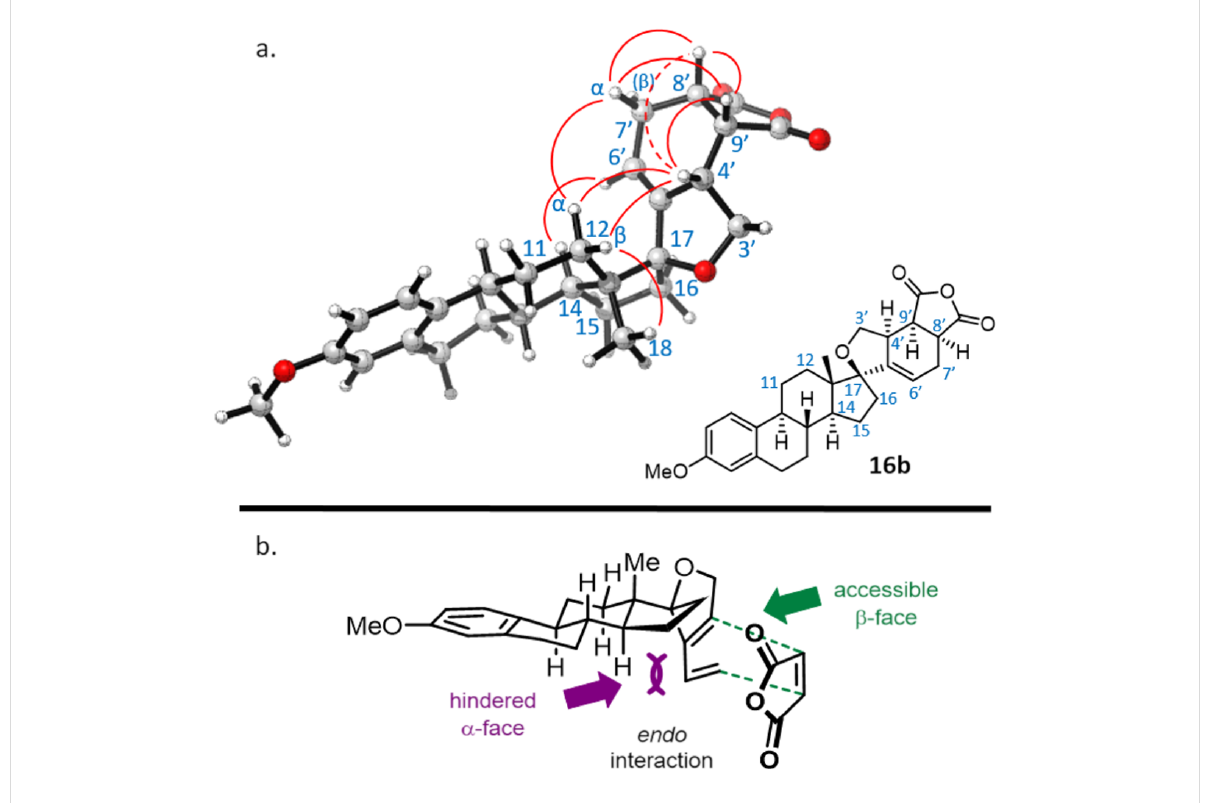
Figure 3: Rationale for the observed stereochemistry: (a) NOESY correlations observed on compound 16b , showing key correlations between protons of the cyclohexene α -face and both protons H-12 (the dotted line indicates a weak correlation); (b) Model to explain the diene–dienophile interaction during the Diels–Alder